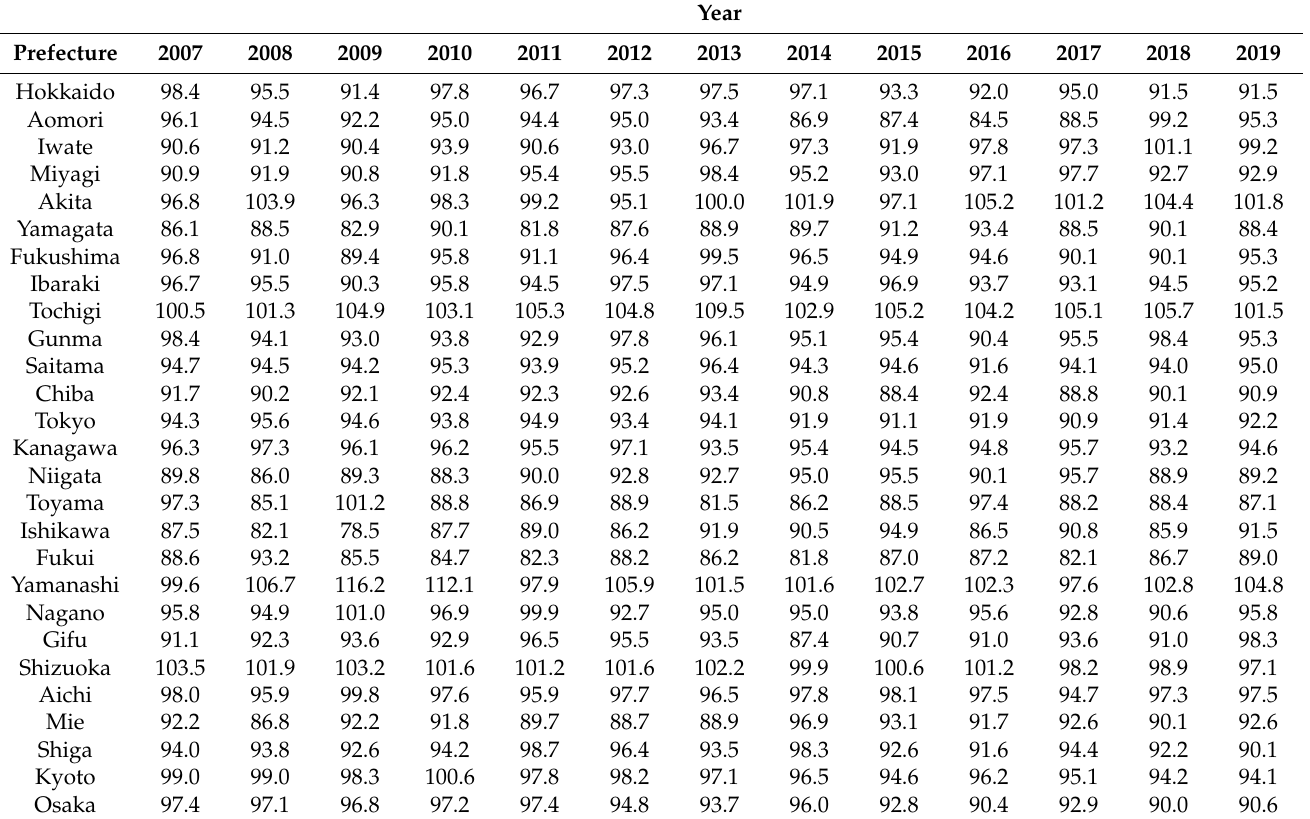
Table 2. Annual rate of overall low birth weight per 1000 births for each prefecture.